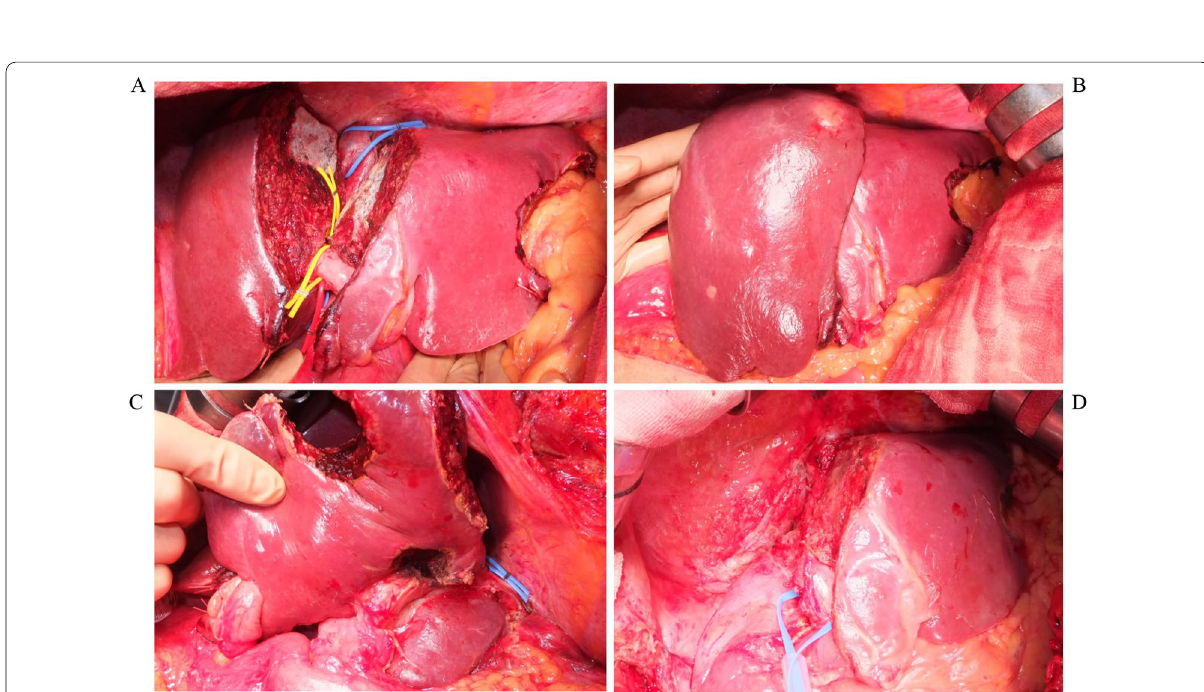
Fig. 4 Intraoperative findings at stages 1 and 2. Panels a to c show liver status at the conclusion of stage 1. Panel d shows status after right trisectionectomy at stage